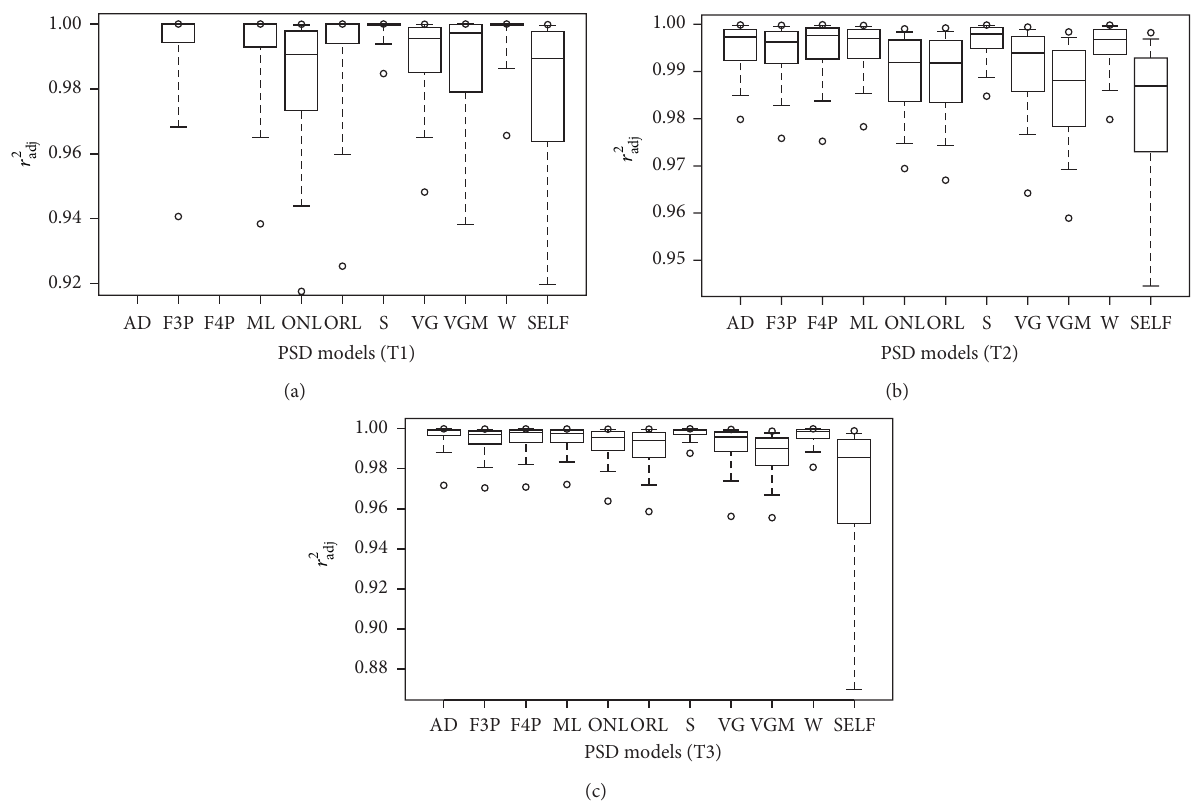
Figure1:Boxplotfor 𝑟 2 percentilesasthegoodness-to-fitof11models,(a)T1schemesoils,(b)T2schemesoils,and(c)T3schemesoils.AD= adj Anderson model, F3P = Fredlund3P model, F4P = Fredlund4P model, ML = modified logistic growth model, ONL = offset-nonrenormalized lognormal model, ORL = offset-renormalized lognormal model, S = Skaggs model, VG = van Genuchten type model, VGM = van Genuchten type modified model, W = Weibull model, and SELF = self-similar model. There is no box plot for AD and F4P model because 𝑟 2 calculated for